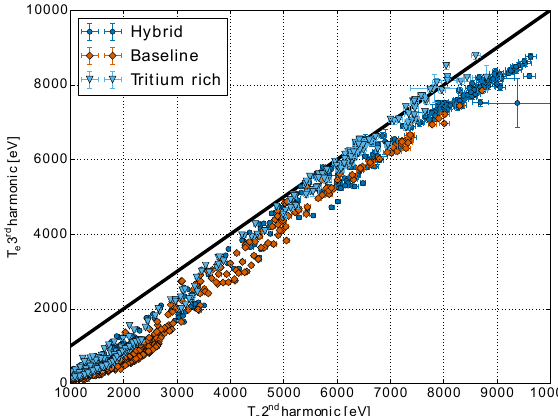
Figure 5: Comparison of central ECE and LIDAR temper- atures for DT pulses.